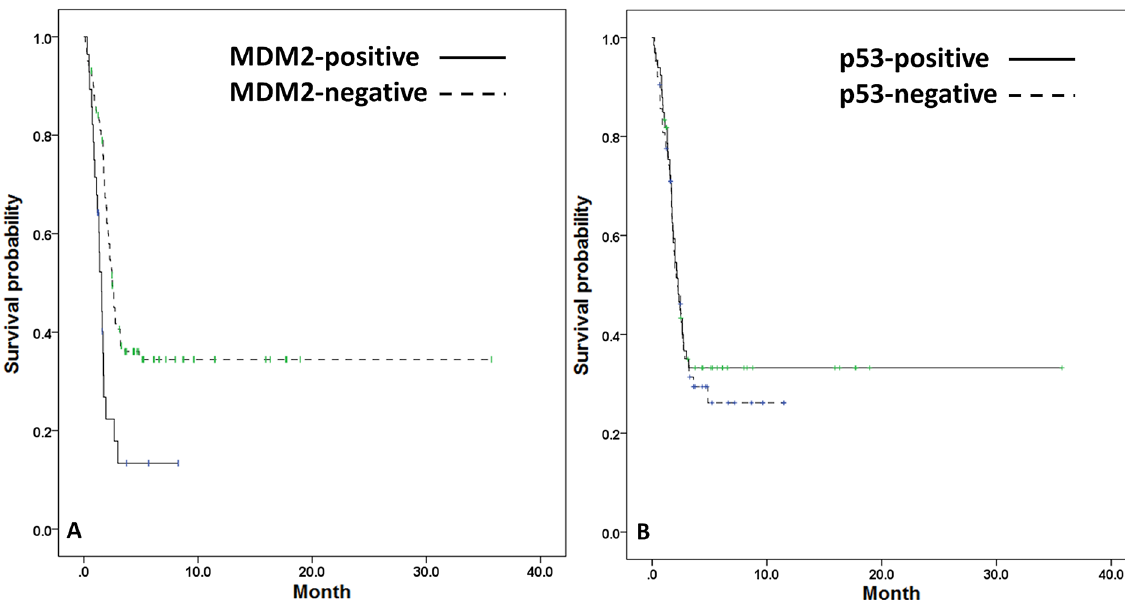
Fig 3. PFS curves in patients stratified with MDM2 and p53. The PFS curves were stratified with (A) MDM2 expressionand (B) p53 expression. The median PFS was worse in patients with MDM2+ IHC staining( P < .001). The median PFS did not differ significantly betweenp53+ and p53- patients ( P = .630). The dots represented censoredobservation.